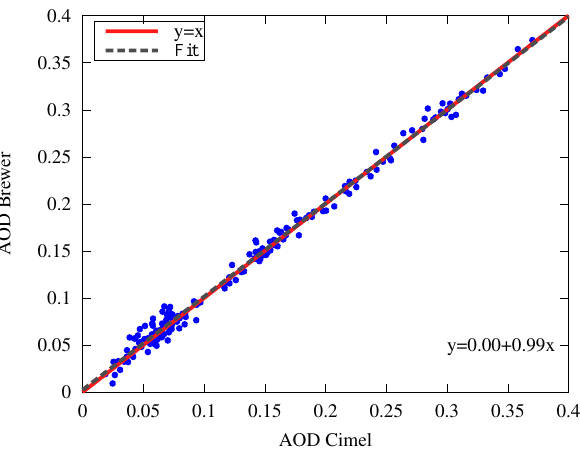
Figure 6. AODs measured by the Brewer at the wavelength of 437nm in the overlapping period 2008–2014.